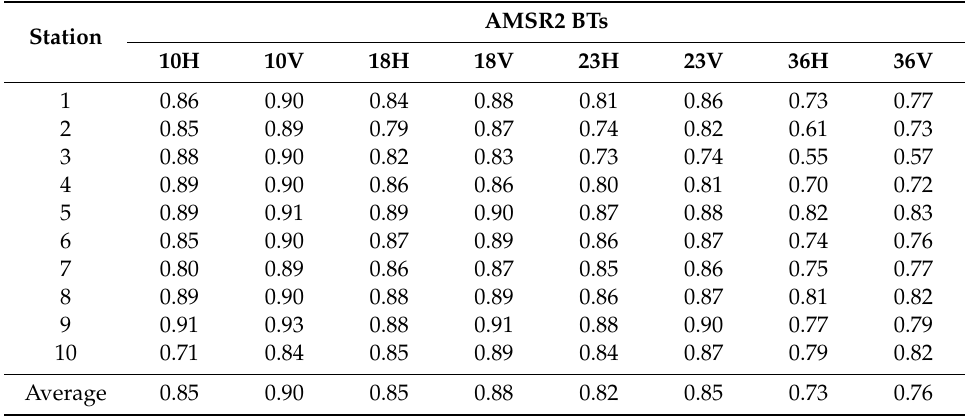
Table A3. The temporal correlation (Pearson correlation coe ffi cient; R) results between eight AMSR2 BTs and the 1 km bias-corrected in situ LSTs during July and August from 2013 to 2018 for the 10 stations in daytime. Refer to Figure 1 for station